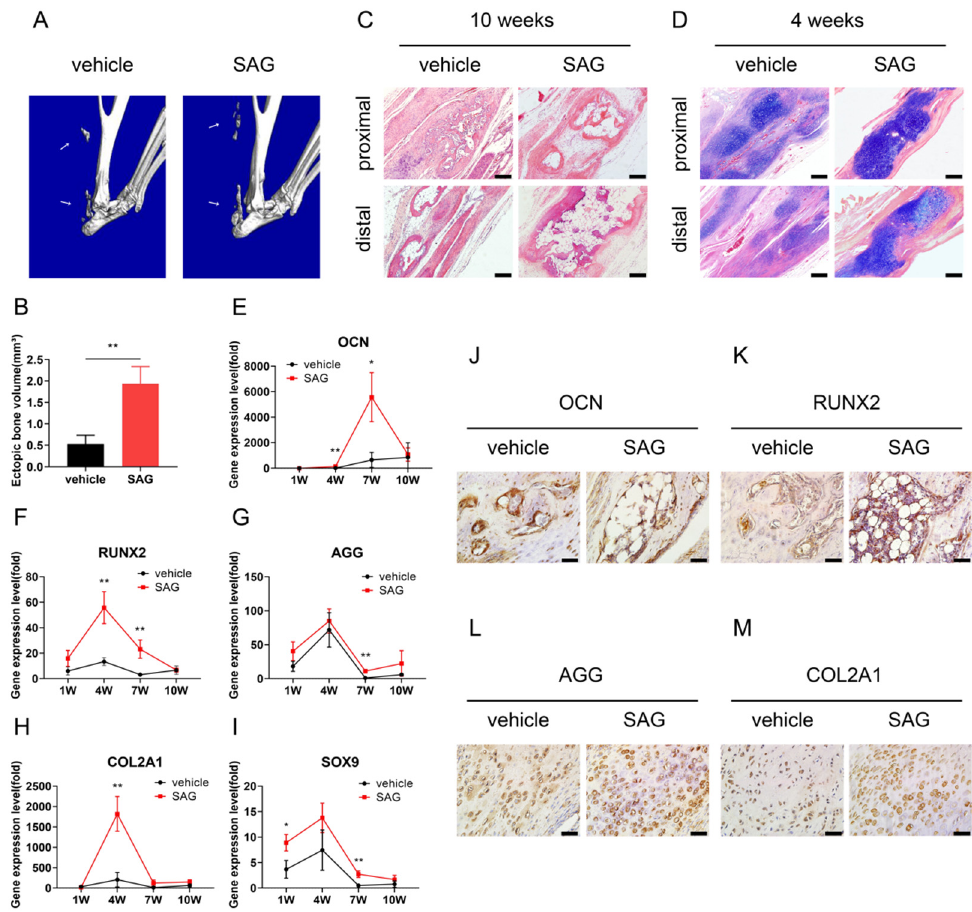
Figure 4. Upregulation of Hedgehog signalling promotes formation of endochondral ossification in injured tendons. ( A ) Micro-CT images of the vehicle and SAG groups 10 weeks postinjury. ( B ) Quantification of the volume of ectopic mineralized bone. ( C ) H&E staining of the vehicle and SAG groups 10 weeks postinjury. Scale bar = 100 µ m. ( D ) Alcian blue staining of the vehicle and SAG groups 4 weeks postinjury. Scale bar = 100 µ m. ( E – I ) qRT–PCR analysis of osteogenic-specific genes such as OCN ( E ) and RUNX2 ( F ) and chondrogenic-specific genes such as AGG ( G ), COL2A1 ( H ), and SOX9 ( I ) in tendon specimens of the vehicle and SAG groups 1, 4, 7, and 10 weeks postinjury. ( J , K ) Images of IHC staining of OCN ( J ) and RUNX2 ( K ) in the tendons of the vehicle and SAG groups 10 weeks postinjury. Scale bar = 20 µ m. ( L , M ) Images of IHC staining of AGG ( L ) and COL2A1 ( M ) in the tendons of the vehicle and SAG groups 4 weeks postinjury. Scale bar = 20 µ m. * p < 0.05, ** p <